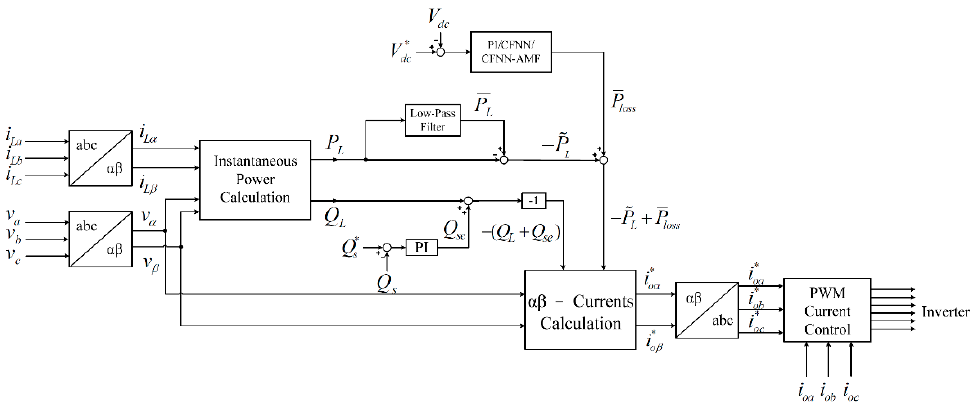
Figure 2. Control block of DSTATCOM.